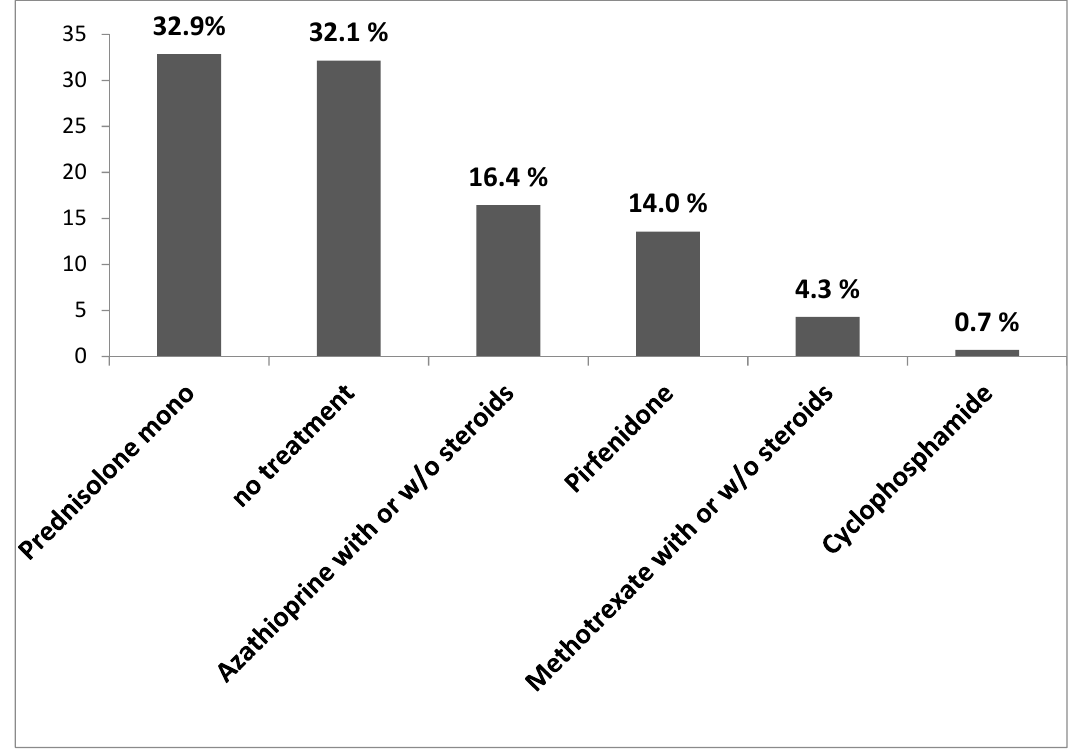
Figure 5. Treatment in uILD cohort. The data are presented as percentage of all uILD patients.